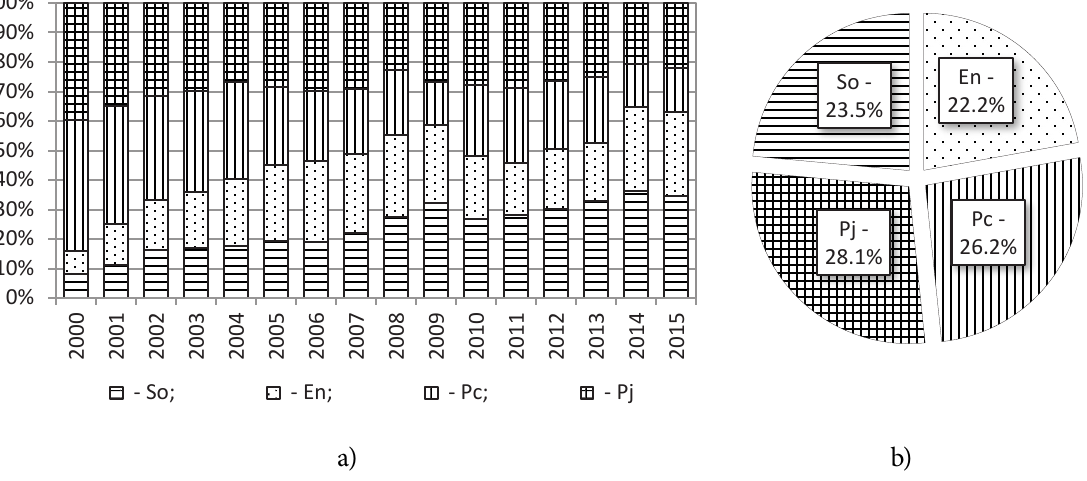
Figure 3. Graphical representation of the subsystems proportions in general structure of the socio-economic system of the country: a) in dynamics by years; b) on average for the analyzed period